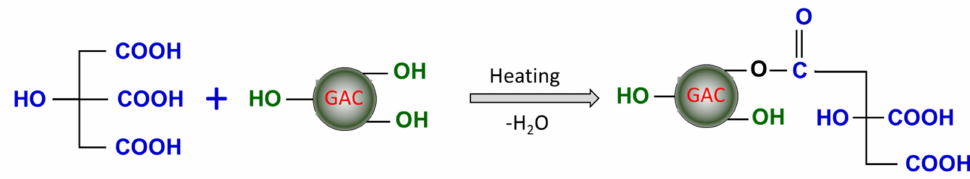
Figure 2. Citric acid modification of granular activated carbon